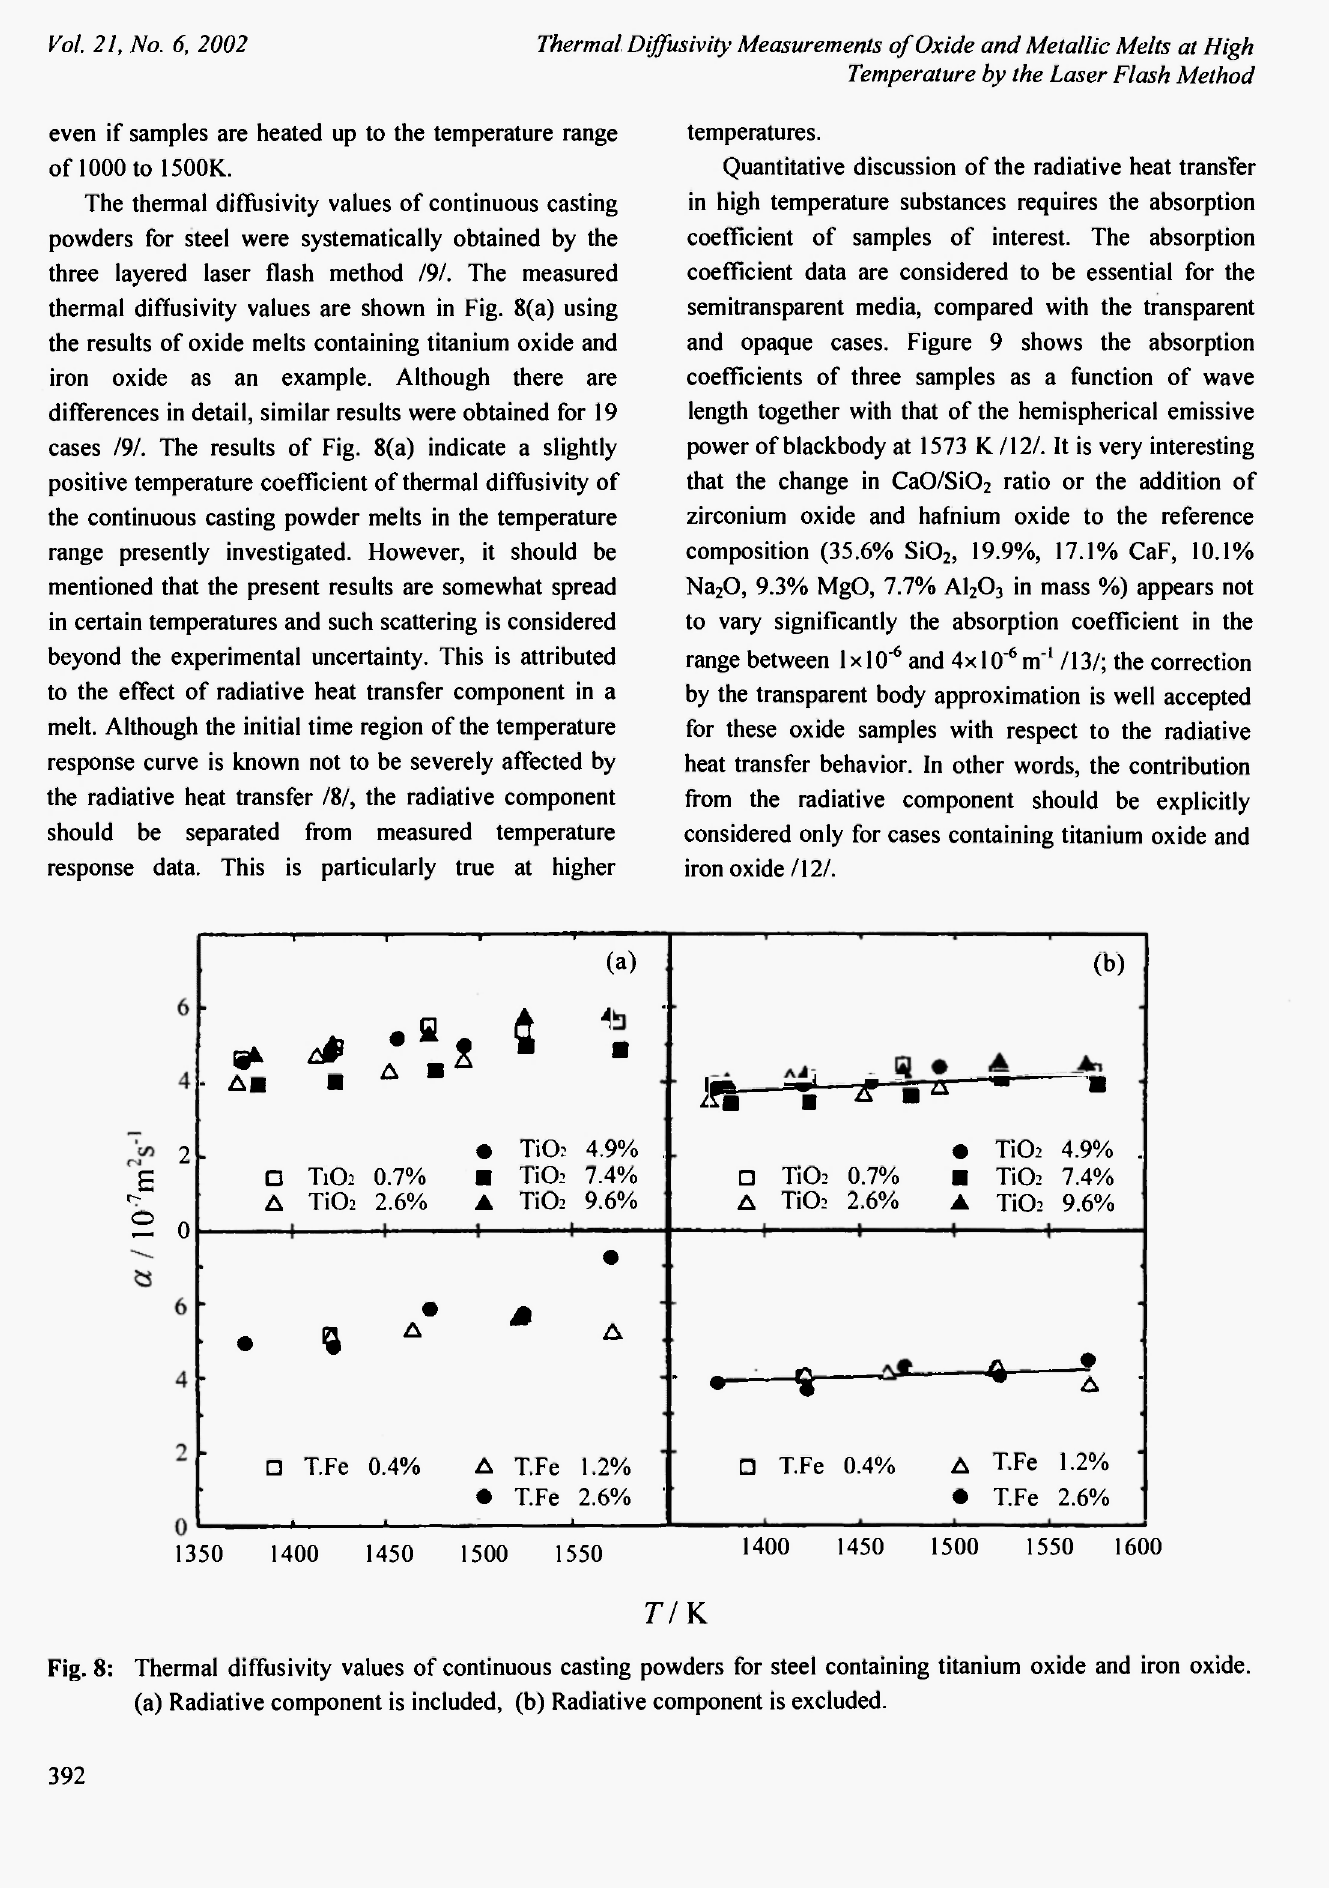
Fig. 8: Thermal diffusivity values of continuous casting powders for steel containing titanium oxide and iron oxide, (a) Radiative component is included, (b) Radiative component is